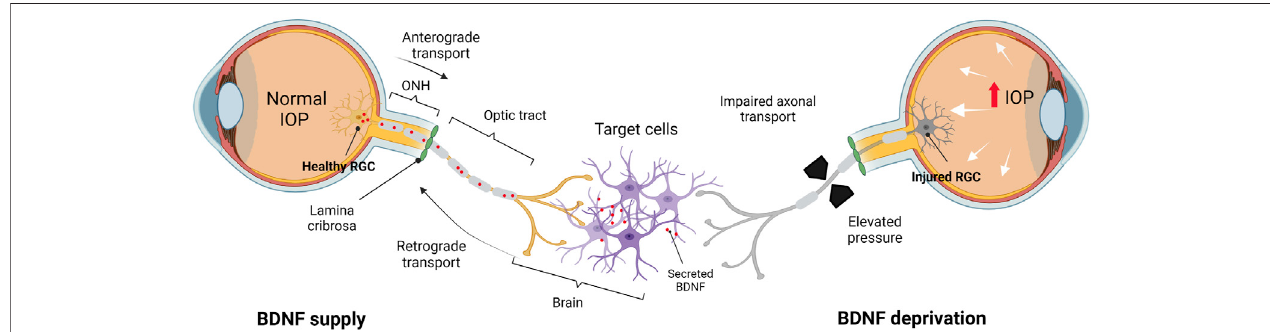
FIGURE 2 | BDNF deprivation theory in the adult human visual system. BDNF supply: in healthy conditions, BDNF is synthesized and secreted by cells in the brain and transported retrogradely via the optic nerve toward the somas (RGCs). BDNF deprivation: axonal transport is perturbed due to the elevated IOP and RGCs are deprived of target-derived (brain) BDNF, leading to the stressed RGCs undergoing apoptosis. IOP, intraocular pressure; ONH, optic nerve head. Created by Biorender. com